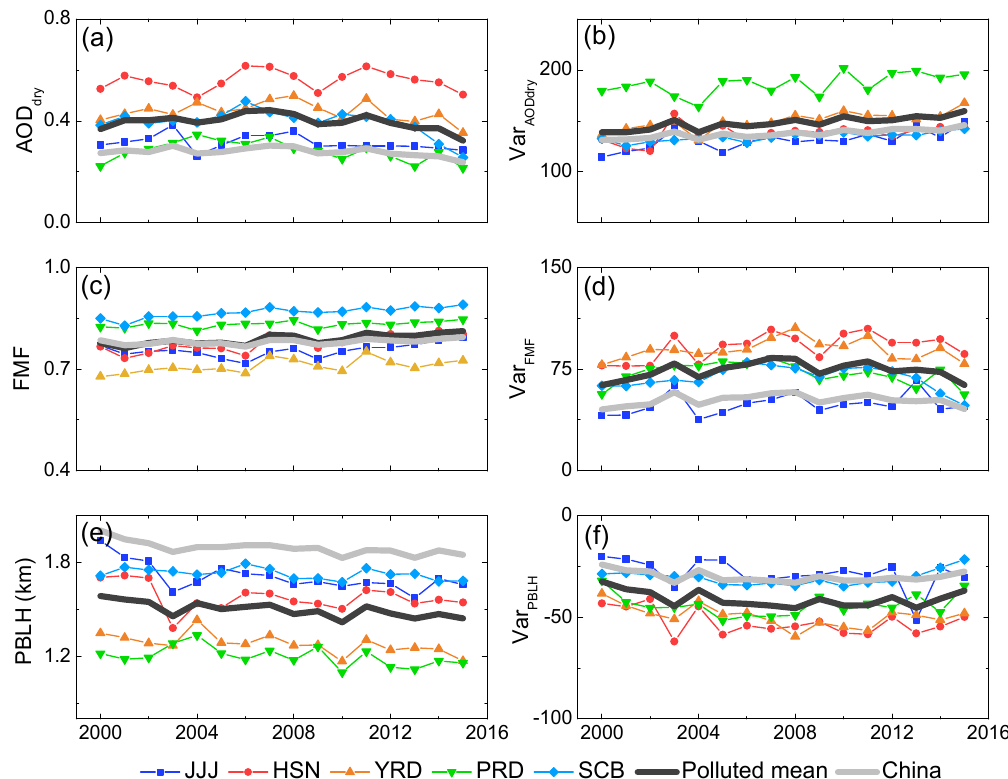
Figure 8. Time series of key parameters (( a ) AOD dry , ( c ) FMF and ( e ) planet boundary layer height (PBLH)) and their variability ( Var ) ( b , d , f ) in the particulate matter remote sensing (PMRS) model over China, for five selected regions, and the averages over all five polluted regions and over all China as indicated at the bottom of the figure. The unit of Var AOD,dry and Var FMF is µ g m − 3 , that of Var PBLH is µ g m − 3 km − 1 .